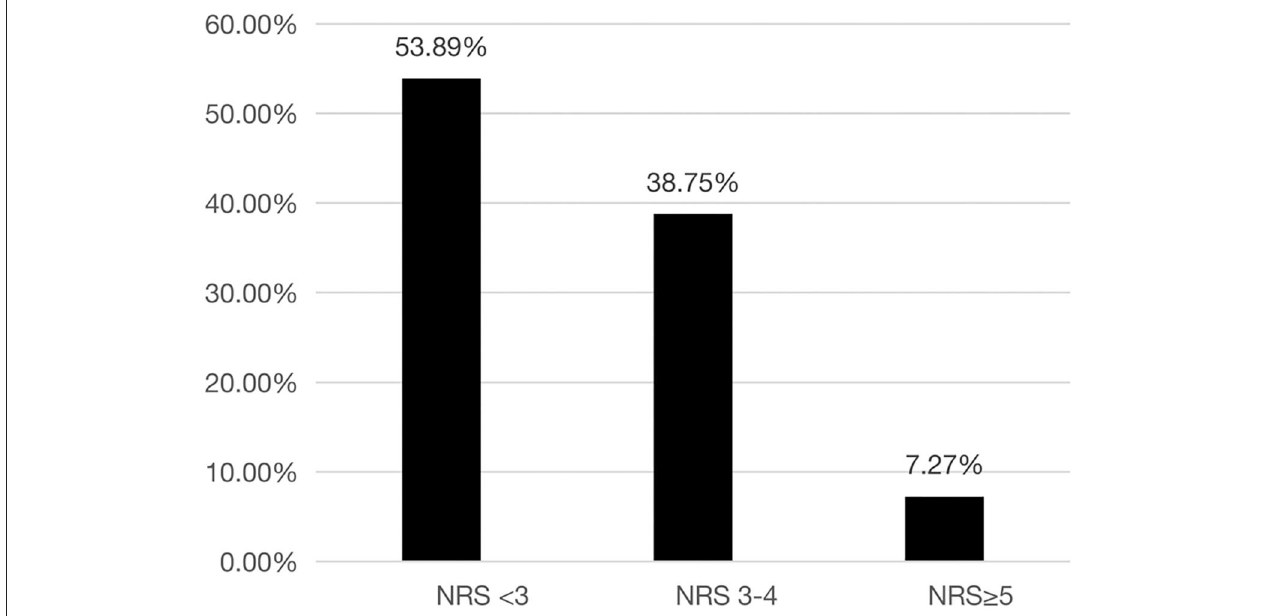
FIGURE 1 | Distribution of different NRS-2002 score stratifications among the patients hospitalized in the Department of Respiratory and Critical Care Medicine of Tibet Autonomous Region People’s Hospital. NRS-2002, Nutrition Risk Screening 2002.